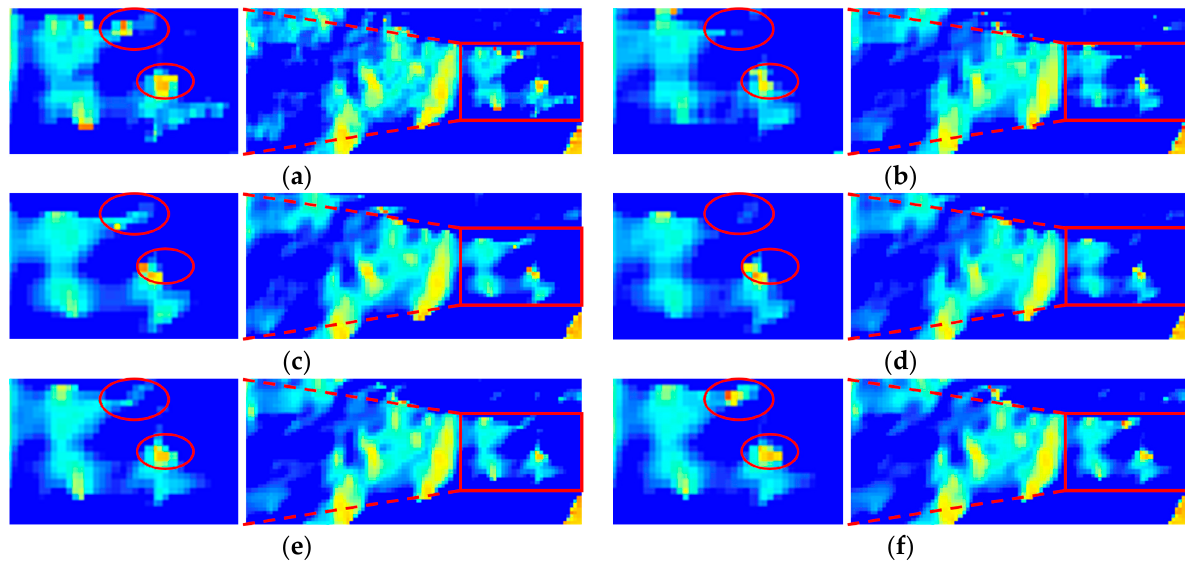
Figure 10. Comparison of the results of the original high-resolution DEM with the five DEM super- resolution reconstruction methods: ( a ) Original, ( b ) Bicubic, ( c ) SRCNN, ( d ) VDSR, ( e ) ZSSR, ( f )